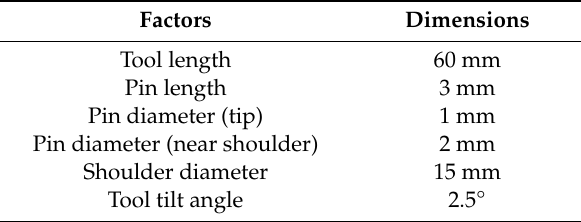
Figure 1. Geometrical dimensions of the tool (all dimensions in mm). Table 4. Geometrical dimensions of the friction stir welding (FSW) tool.